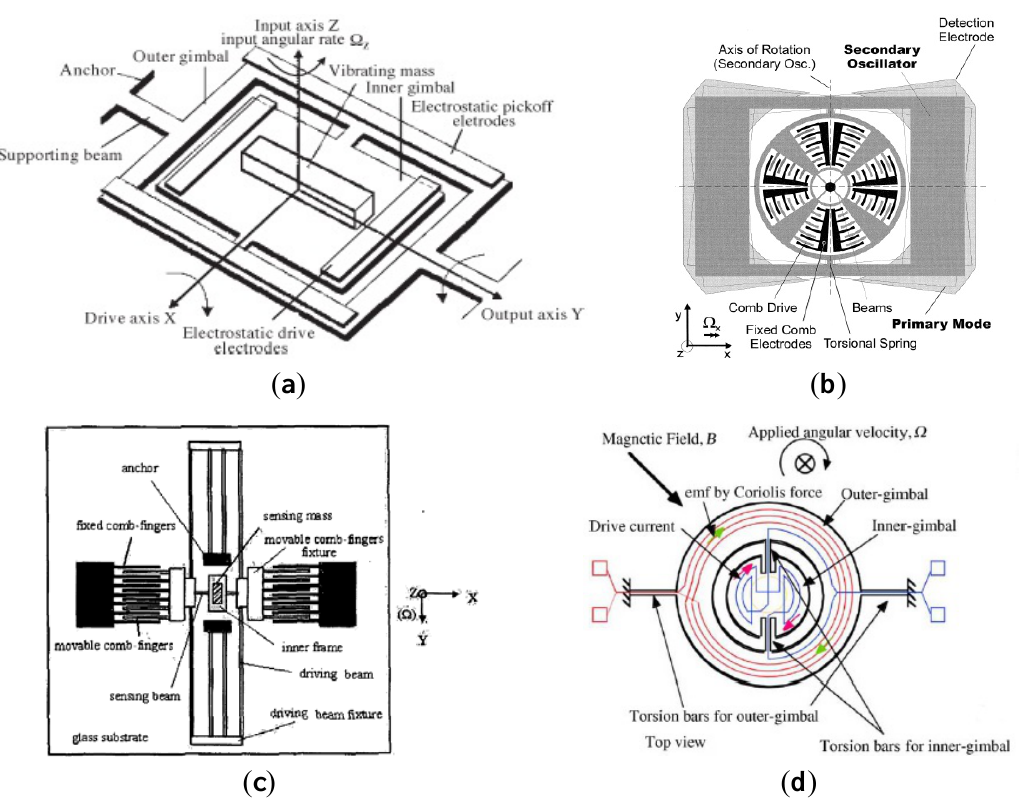
Figure 5. Various gimbal gyroscopes. ( a ) Draper Laboratory gimbal gyroscope. ( b ) HSG-IMIT MARS-RR. ( c ) SIMIT comb-gimbal gyroscope. ( d ) University of Hyogo gimbal